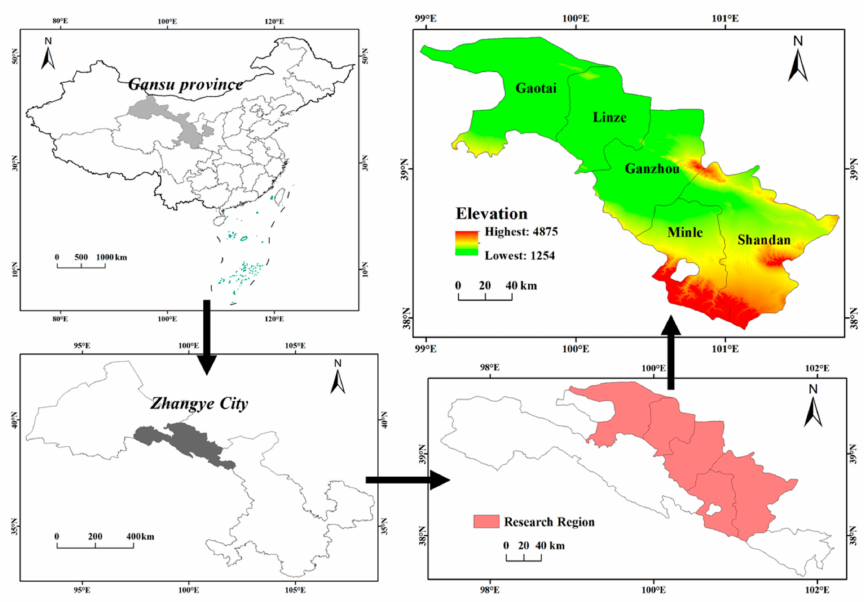
Figure 1. Location and elevation of Zhangye